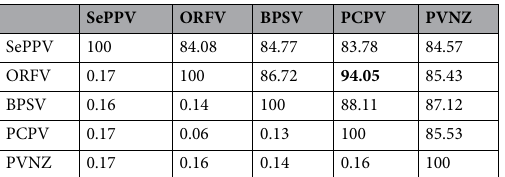
Table 3. Percentage amino acid identity between the DNA polymerase within the genus parapoxvirus. Upper comparison gradient indicates percentage identity between two sequences; lower comparison gradient indicates the distance between two sequences as calculated by the distance measure Jukes-Cantor. Percentage identity higher than 90% is shown in bold numbers.